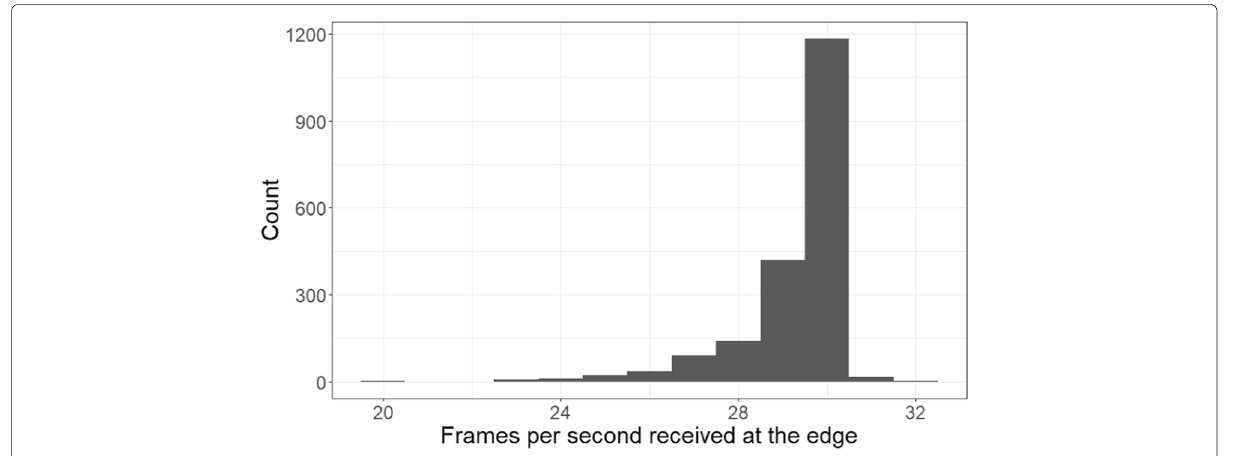
Fig. 12 Experimental frame arrival rate at the edge device